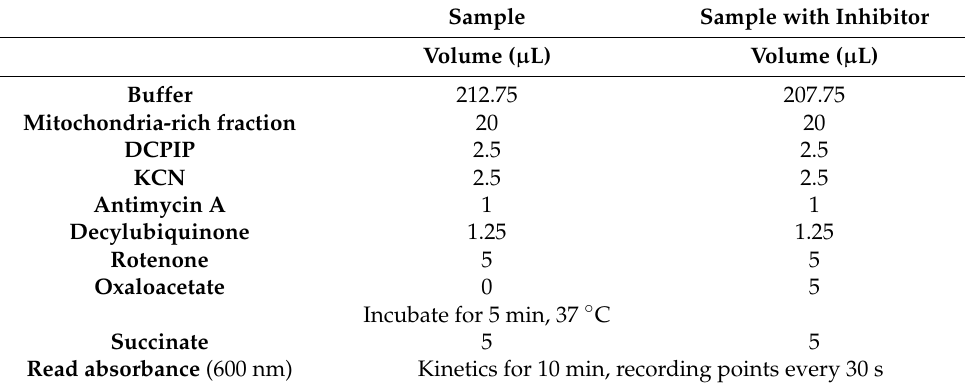
Table 6. Conditions and flow setup for Complex II activity